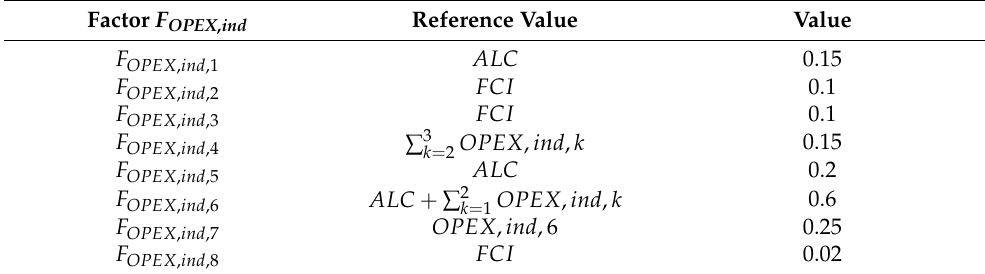
Table 6. Factors for calculation of indirect OPEX.